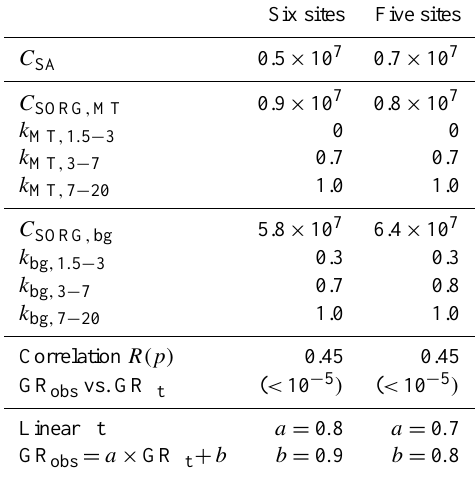
Table 4. Average concentrations of SORG MT ( C SORG , MT , cm − 3 ) and sulfuric acid ( C SA , cm − 3 ) as well as the background concentra- tion ( C SORG , bg , cm − 3 ) and weighing factors ( k MT and k bg ) from the mass flux fit using EUCAARI data (including and excluding Hyyti¨al¨a). Monthly median growth rates were averaged over all the six European stations (Hyyti¨al¨a included, 2003–2009). Pear- son’s correlation coefficients ( R ) with p values (in parentheses) and parameters a and b (nmh − 1 ), obtained from a linear fit between the observed growth rates (GR obs innmh − 1 ) (monthly medians for each station) and the growth rates obtained from the mass flux fit (GR fit in nmh − 1 ), are presented. Six sites Five sites